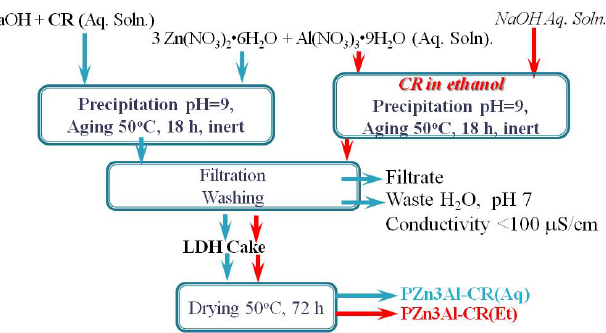
Figure 2. Flowchart for the preparation of curcumin (CR)-containing Zn3Al-layered double hydroxide (LDH) by co-precipitation.